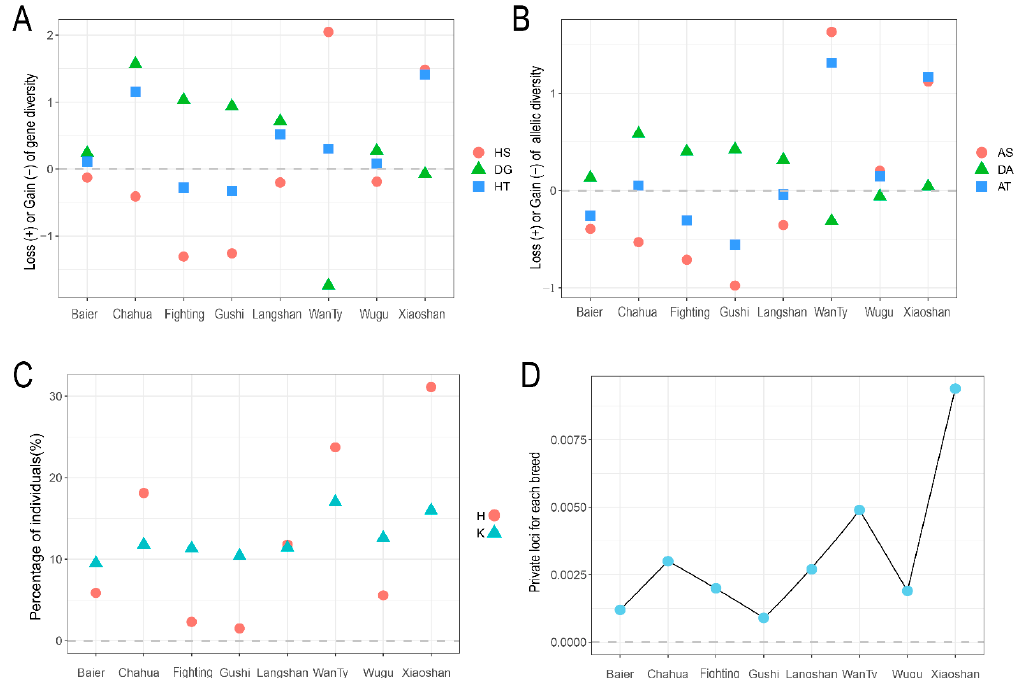
Figure 3. Contribution of the eight native chicken breeds to genetic diversity. ( A ) Loss (+) or gain ( − ) of genetic diversity after sequential removal of each breed. HS is the gene diversity intra-breed, DG is the gene diversity inter-breed, and HT is the total loss or gain of gene diversity. ( B ) Loss (+) or gain ( − ) of allelic diversity after sequentially removal of each breed. AS is allelic diversity intra-breed, DA is allelic diversity inter-breed, and AT is the total loss or gain of allelic diversity; ( C ) contribution of individuals from each breed to pools with the greatest proportion of genetic diversity (H) and allelic diversity (K) proportion. ( D ) Average number of private alleles per locus in each breed.